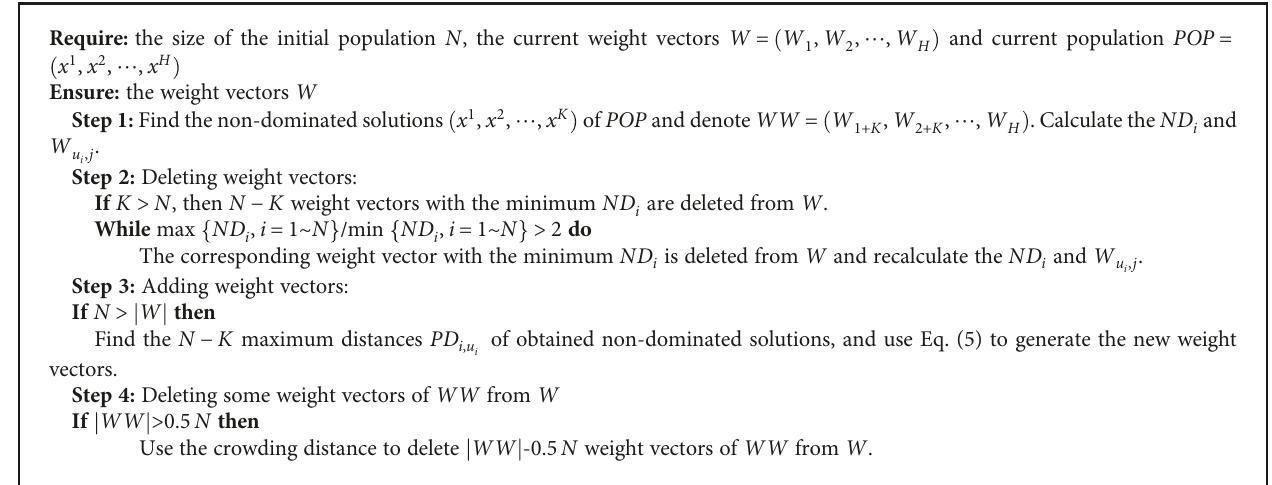
is deleted. (b) Adding strategy: b , d , g , and h are dominated 4 is added. new